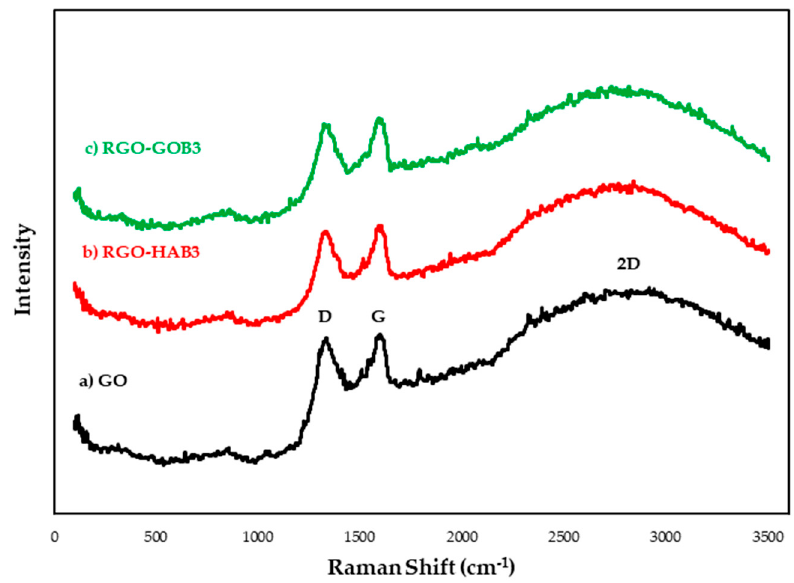
Figure 8. Raman spectrum of GO and RGO with natural extracts. The analyzed samples are: (a) GO (unreduced), (b) RGO-HAB3 20% and (c) RGO-GOB3 20%. Table 3. Raman characteristic parameters of graphite, graphene oxide (GO) and reduced graphene oxide (RGO) samples.